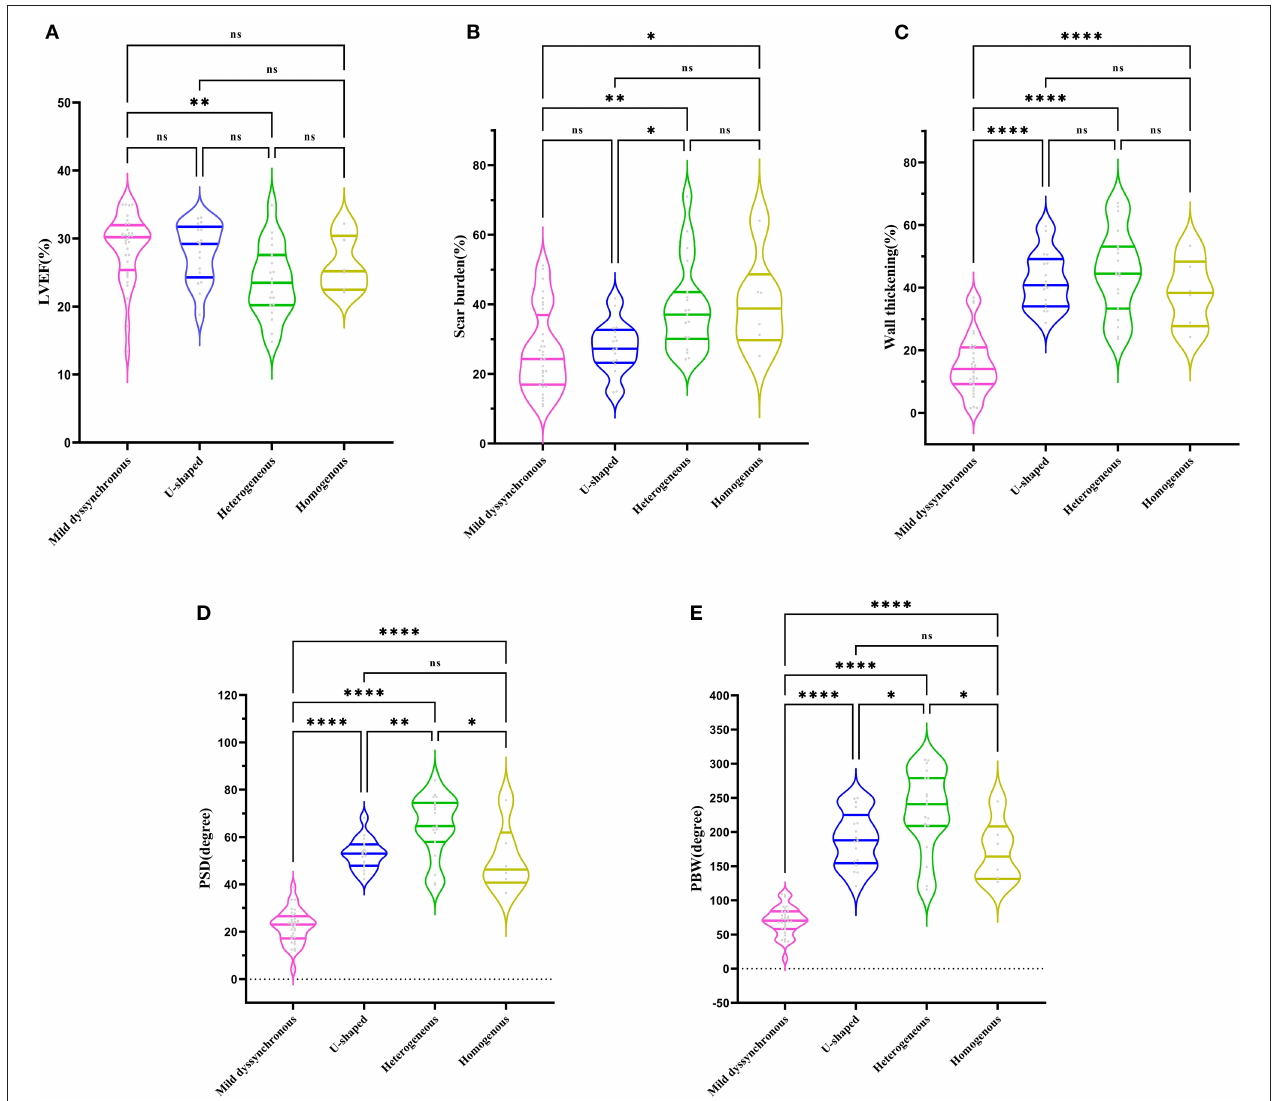
FIGURE 2 | Comparison of LVEF, scar burden, wall thickening, PSD, and PBW in different groups. (A) Mild dyssynchronous group had a similar LVEF with U-shaped and homogenous group, significantly higher than heterogeneous group. (B) Mild dyssynchronous group had a similar scar burden with U-shaped group, significantly lower than heterogeneous group and homogenous group. (C) Mild dyssynchronous group had a lower wall thickening than U-shaped, heterogeneous, and homogenous group. (D) Mild dyssynchronous group had a lower PSD than U-shaped, heterogeneous, and homogenous group. (E) Mild dyssynchronous group had a lower PBW than U-shaped, heterogeneous, and homogenous group. * P < 0.05; ** P < 0.01; **** P < 0.0001. ns, no statistically significant.